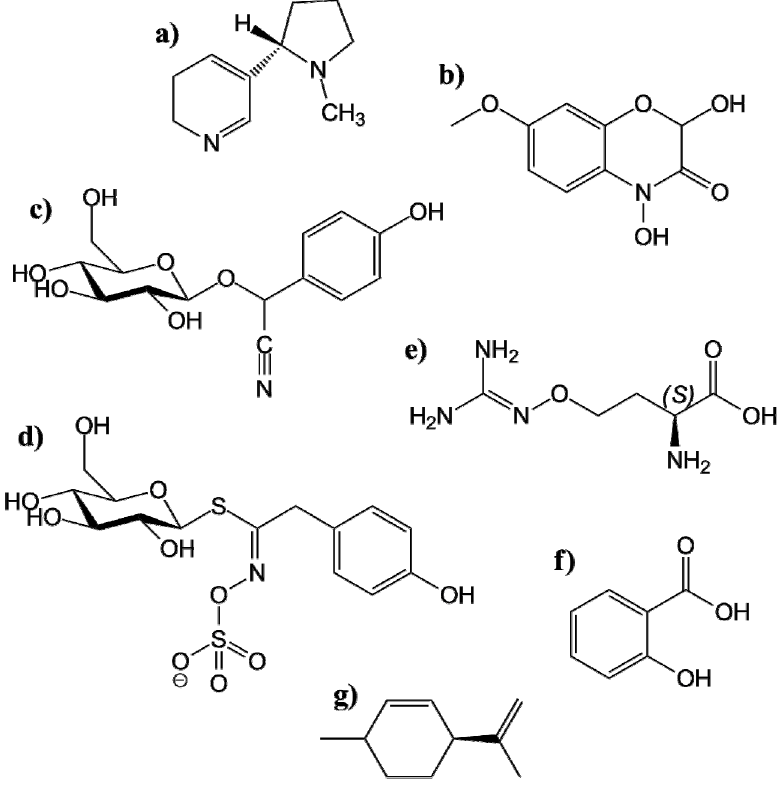
Figure 8. Structures of plant bioactive natural products. ( a ) nicotine, a true alkaloid derived from aspartate and ornithine; ( b ) DIMBOA, a benzoxazinoide derived from indole-3-glycerol phosphate; ( c ) Dhurrin, a cyanogenic glucoside derived from tyrosine, ( d ) Sinalbin, a glucosinolate derived from tyrosine; ( e ) Canavanine, a nonprotein amino acid derived from L -homoserine; (f ) Salicylic acid, a benzoic acid derived phenol; and ( g ) S ( − )-limonene, a terpenoid derived from geranyl pyrophosphate